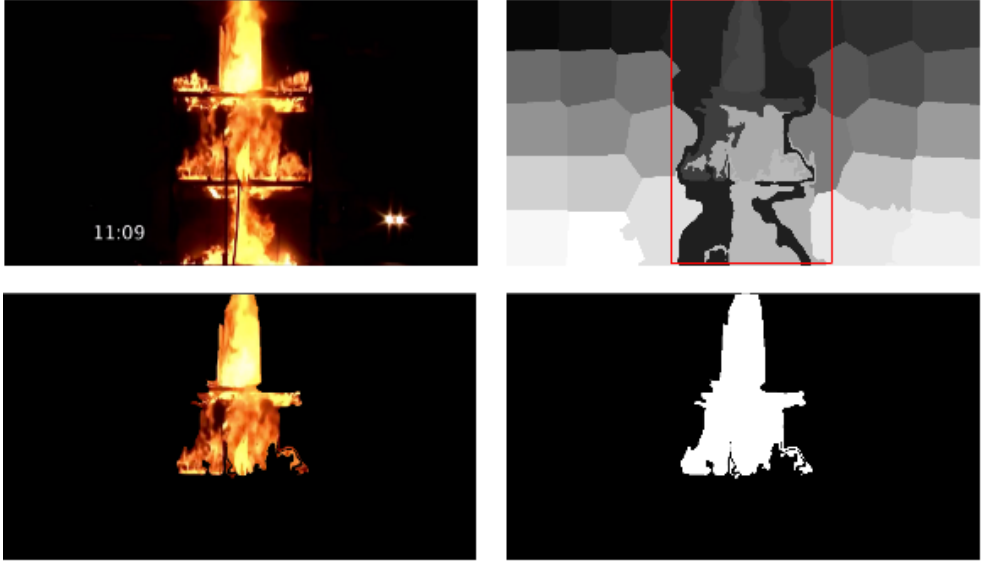
Figure 7. This figure illustrates the processing steps, in order to obtain the segmentation dataset from the bounding box